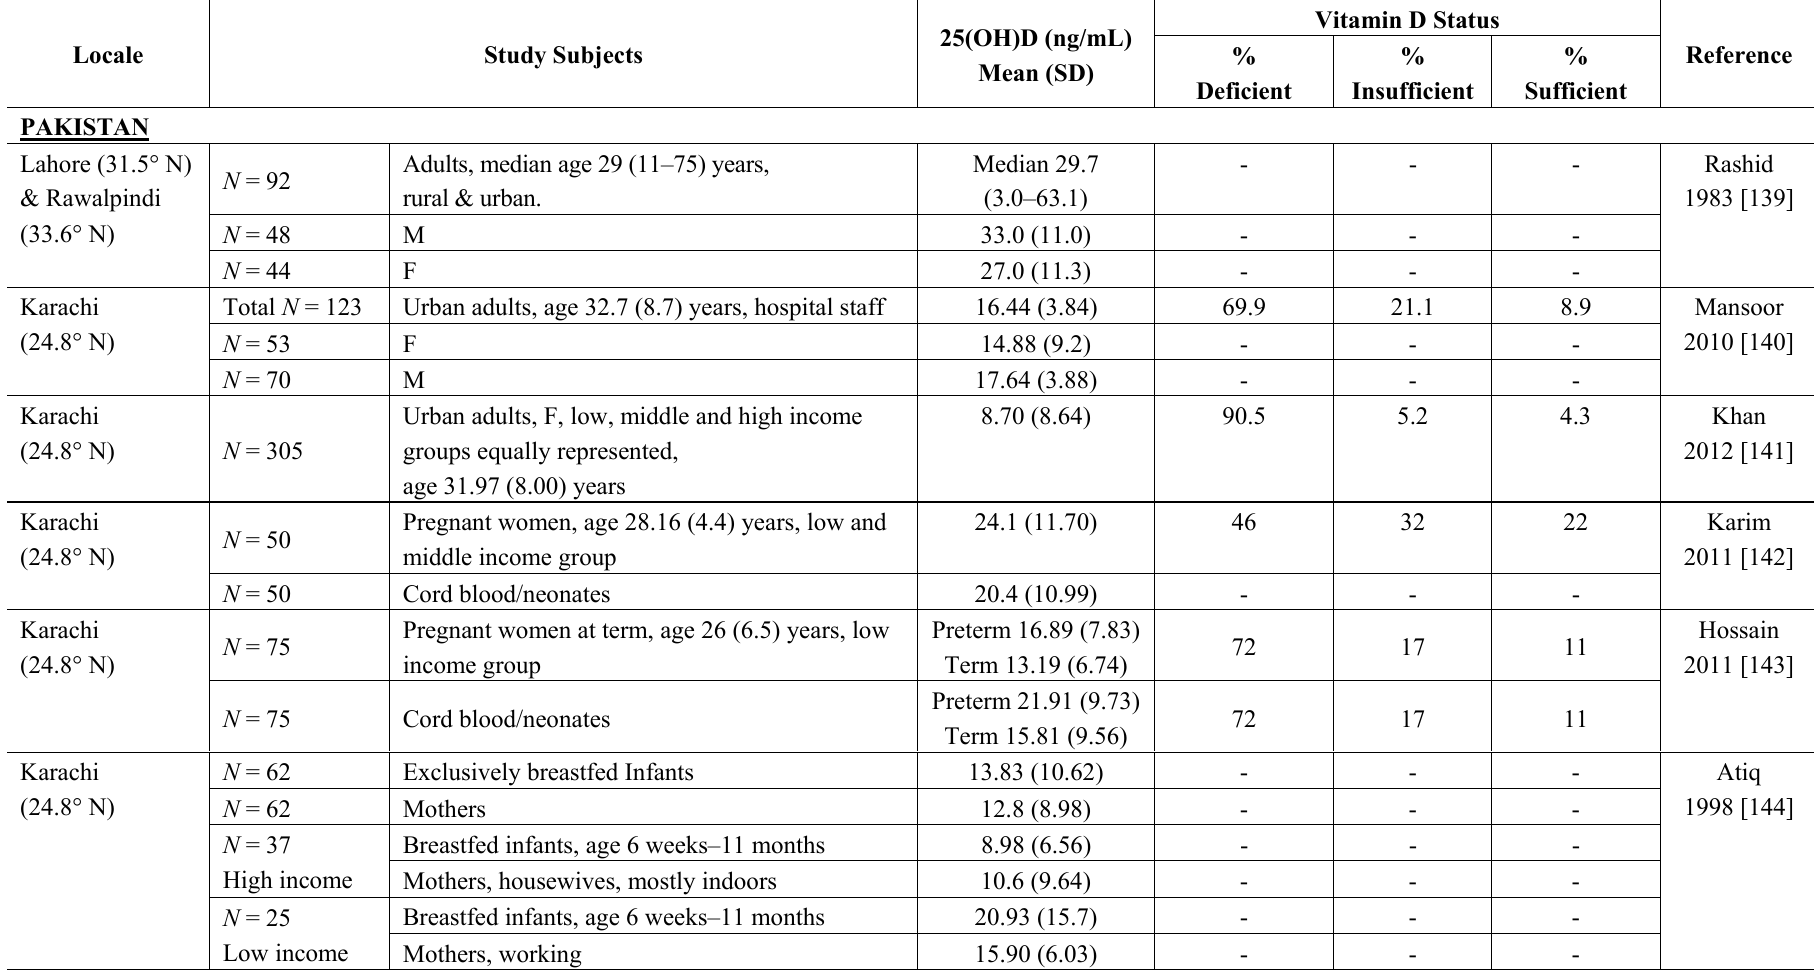
Table 6. Vitamin D status of ostensibly healthy subjects from other countries of the Indian subcontinent. All 25(OH)D values have been shown in ng/mL. To convert from nM to ng/mL, nM values were divided by (2.5). Vitamin D deficiency is defined as 25(OH)D < 20